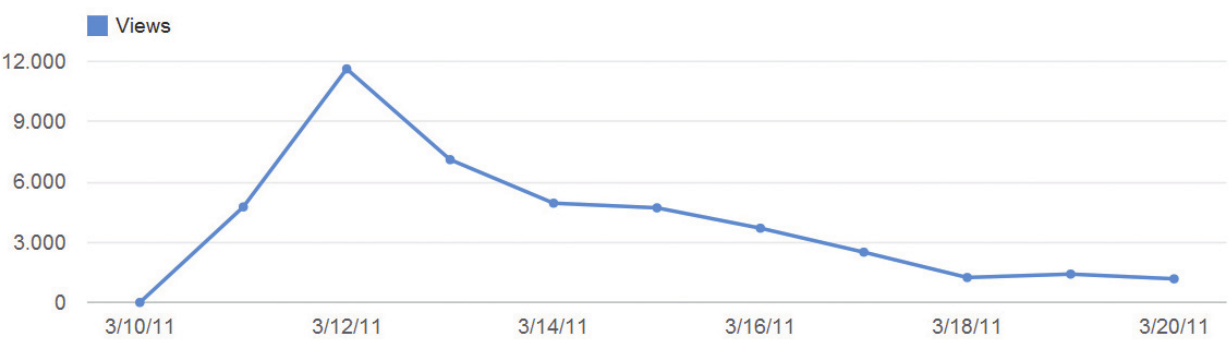
Figure 2. History of daily views for the Tohoku, Japan, video prepared on the afternoon of March 11, 2011, which was viewed by more than 30,000 people in the first four days.